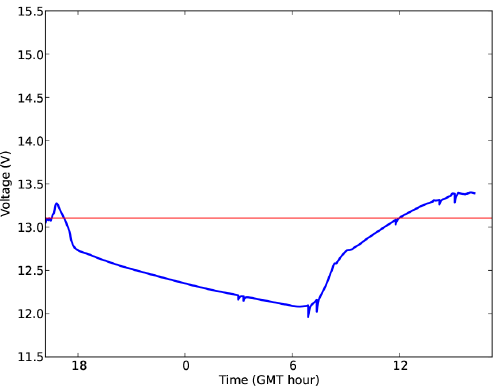
Figure 19. Evolution of external battery charge using a 50W solar Fig. 19: Evolution of external battery charge using 50W solar panel during stormy/cloudy panel during stormy/cloudy weather